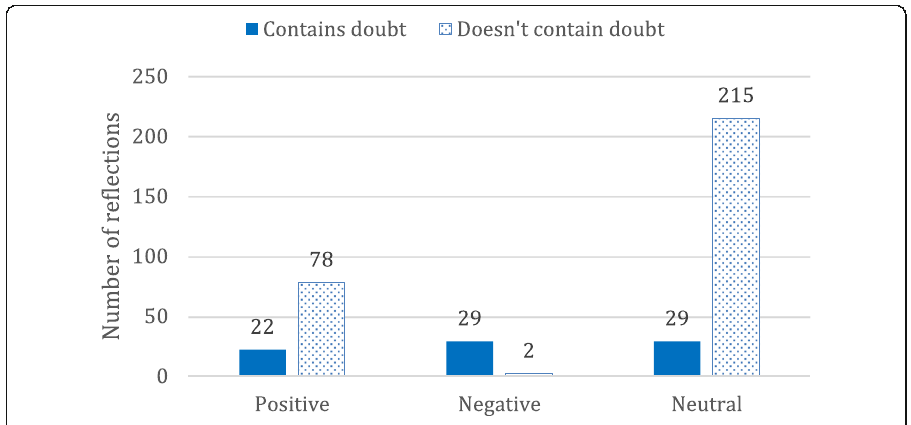
sentiments annotated